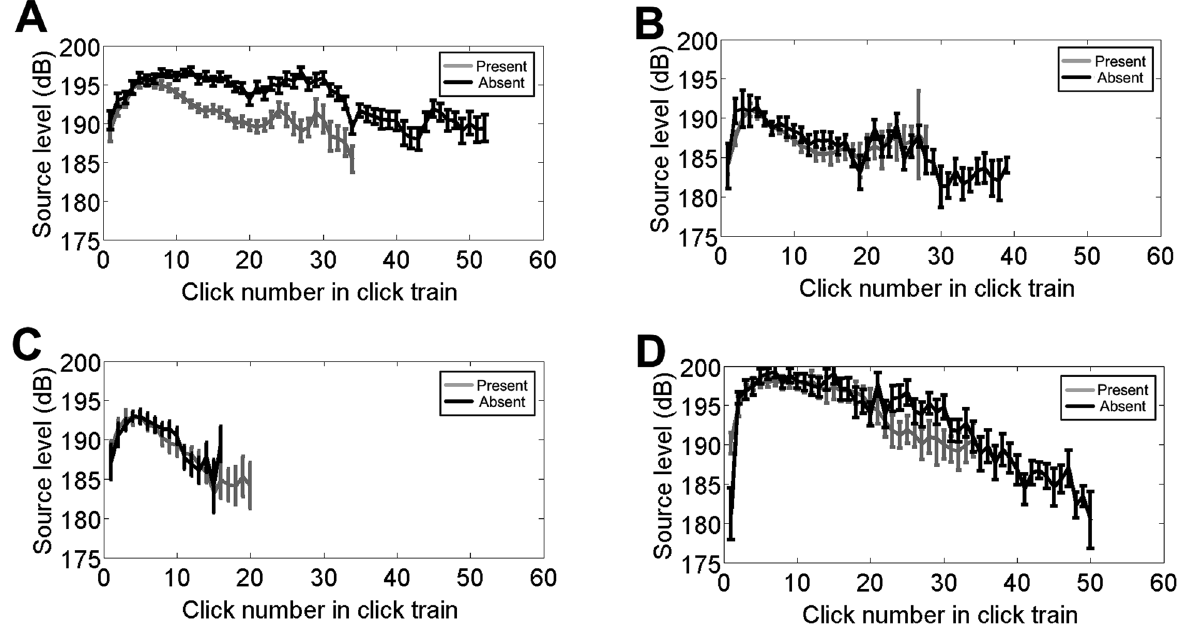
Figure 5. Change in source levels throughout trials according to target distance and presence. Click source levels (mean and standard error) as a function of click number for the unpredictable trials (A), and the 2.5 m (B), 4 m (C), and 7 m (D) predictable target sessions. Clicks within a trial were indexed by click number and then the values of each click number were averaged across all trials. Source levels were calculated from the peak-to-peak voltage and are reported in dB re: 1 m Pa.